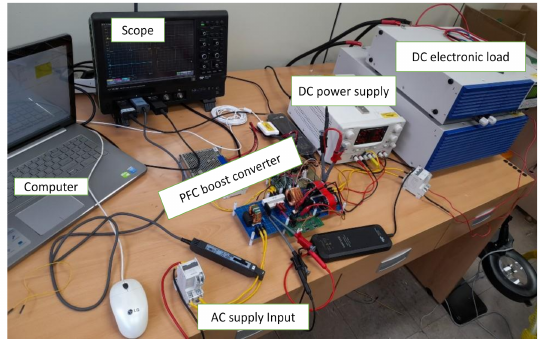
Figure 33. Experimental setup for testing of the designed digitally controlled PFC boost converter.